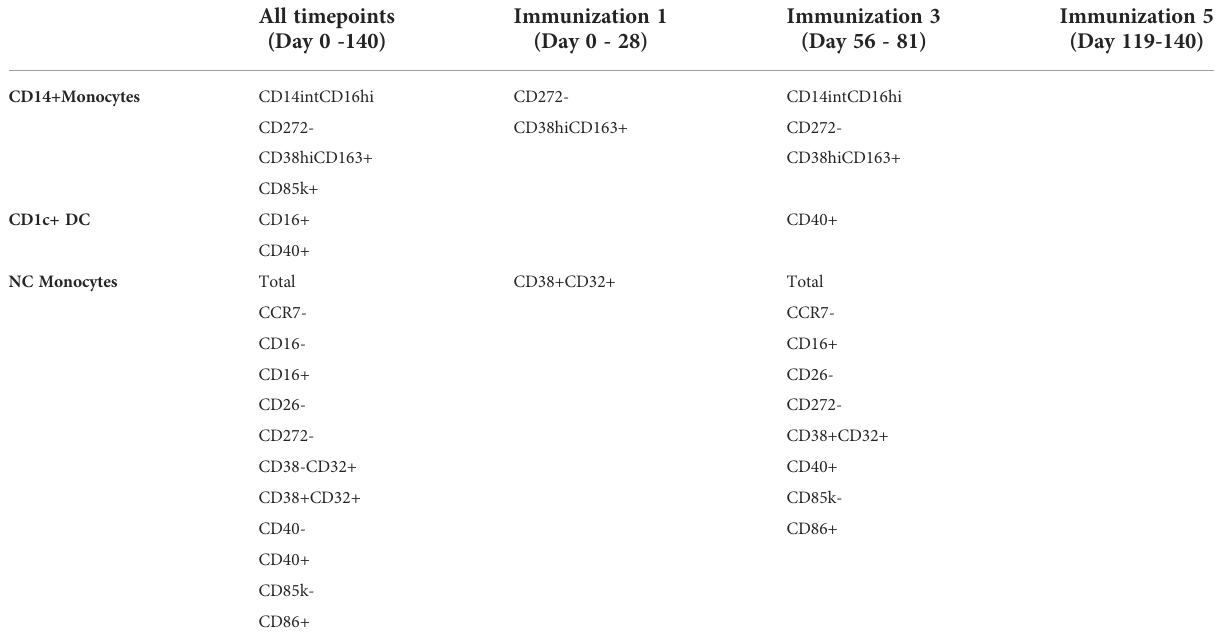
TABLE 2 Numbers of DC/monocyte subsets signi fi cantly (FDR < 0.05) and positively (rho>0.25) correlated with at least one interferon BTM after each